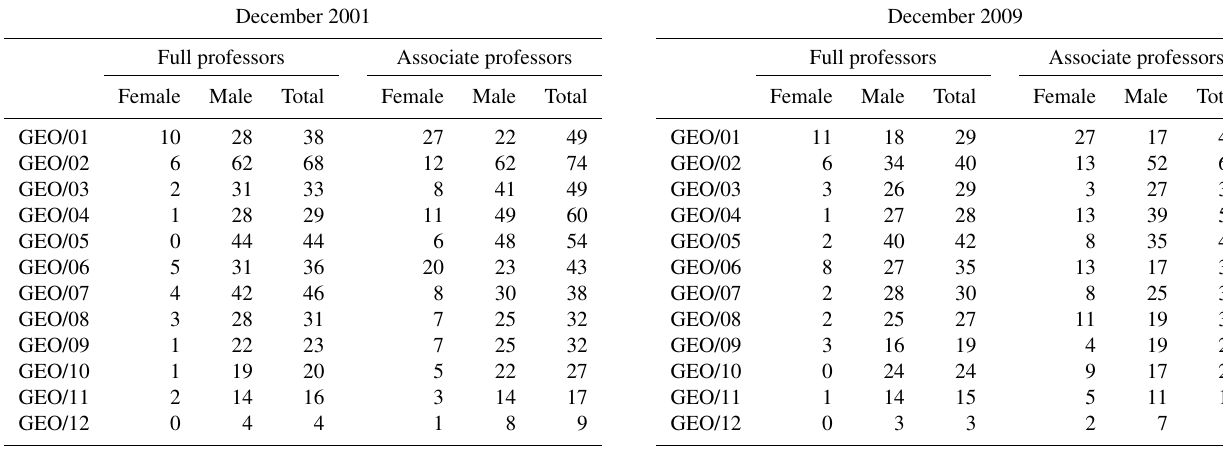
Table 3. Number of full and associate professors in all GEO scien- tific SSD (from 01 to 12) of the Italian university system relative to